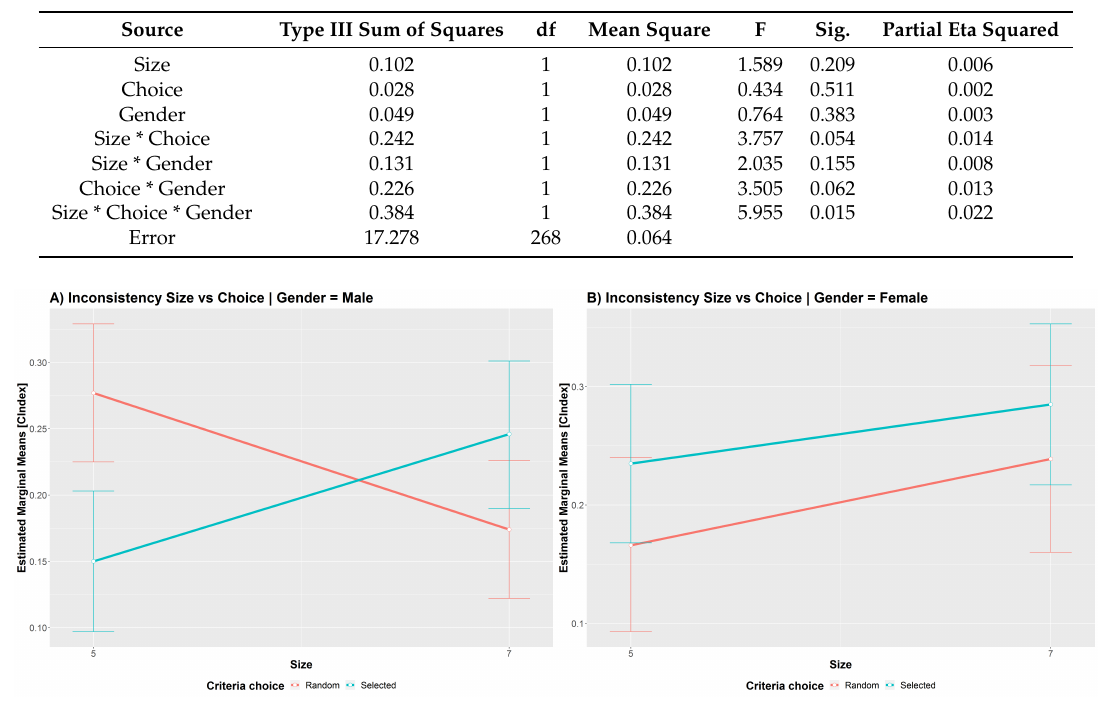
Table 8. Tests of between-subject effects of size, choice and gender.